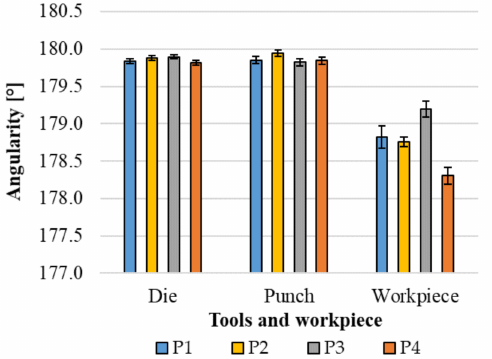
Figure 12. Average angularity of workpiece and tools for the four key